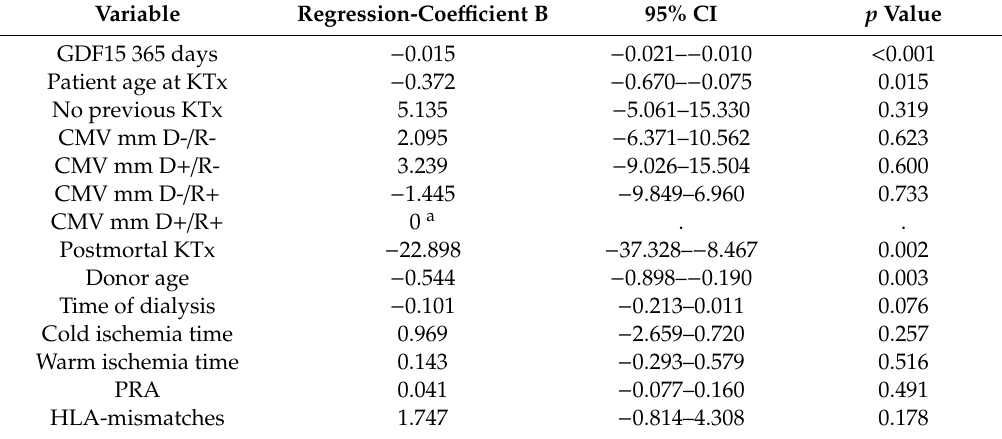
Table 5. Multivariable linear regression model for eGFR two years after KTx.